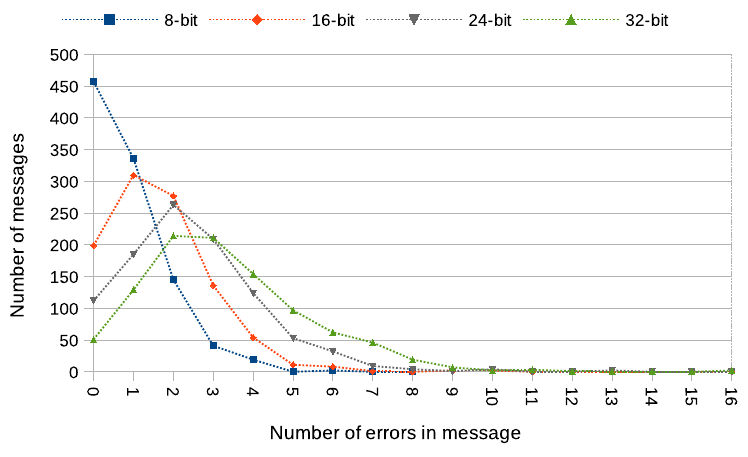
Figure 20. Numbers of messages received with different number of error bits (IEEE 802.11ac; Both-informed).